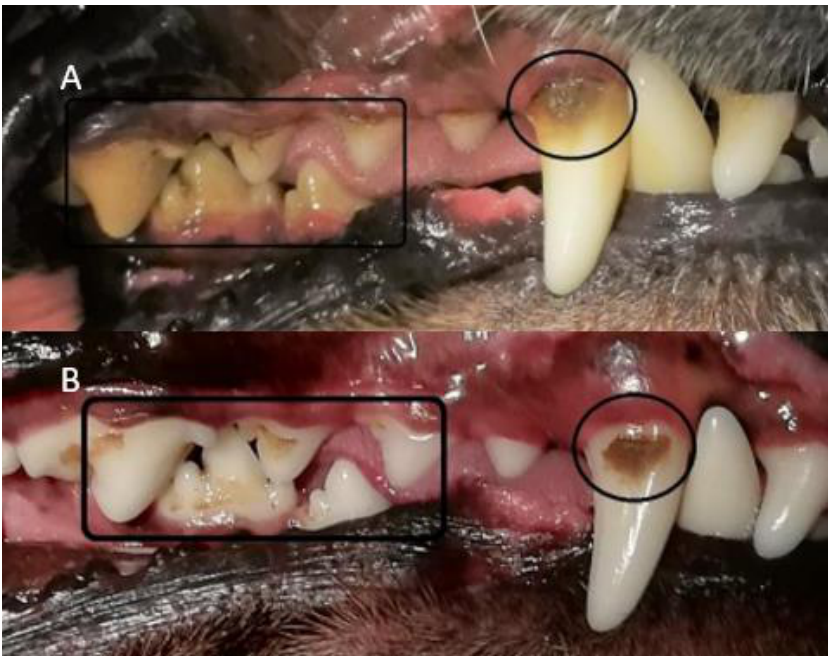
Figure 5. ( A ) The amount of calculus including plaque on the right side at the first assessment before dental cleaning has begun on Toothbrush 3. (Photo: Fanny Eriksson) ( B ) The amount of calculus on the right side at the second assessment on Toothbrush 3 after dental cleaning with manual toothbrushing. The amount of calculus has visibly decreased on all teeth. (Photo: Fanny Eriksson).